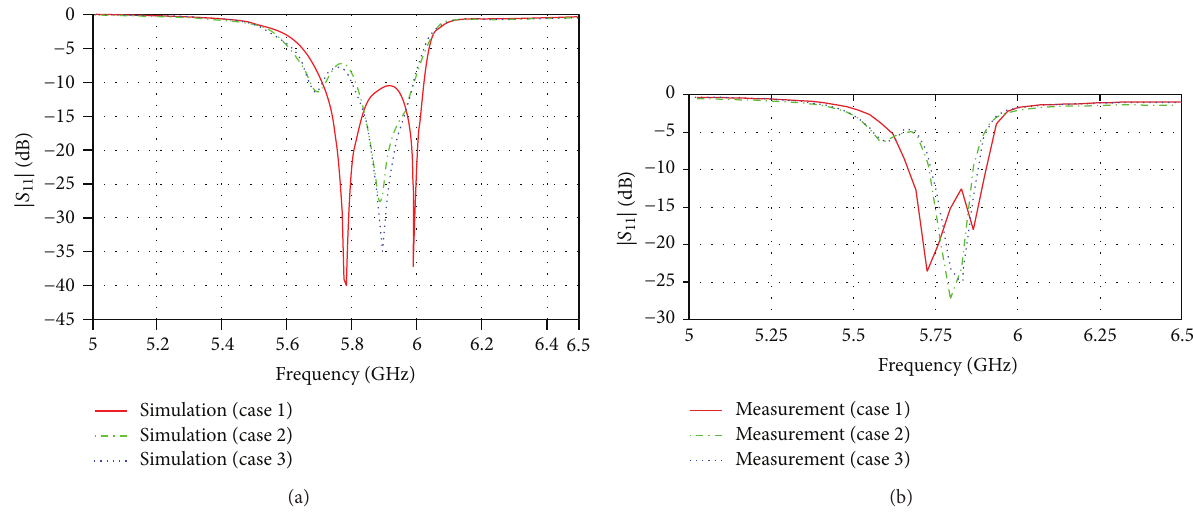
Figure 26: (a) Reflection coefficients of FL-LHM beam steering antenna with ℎ = 30 mm in simulation. (b) Reflection coefficients of FL-LHM beam steering antenna with ℎ = 30 mm in measurement.